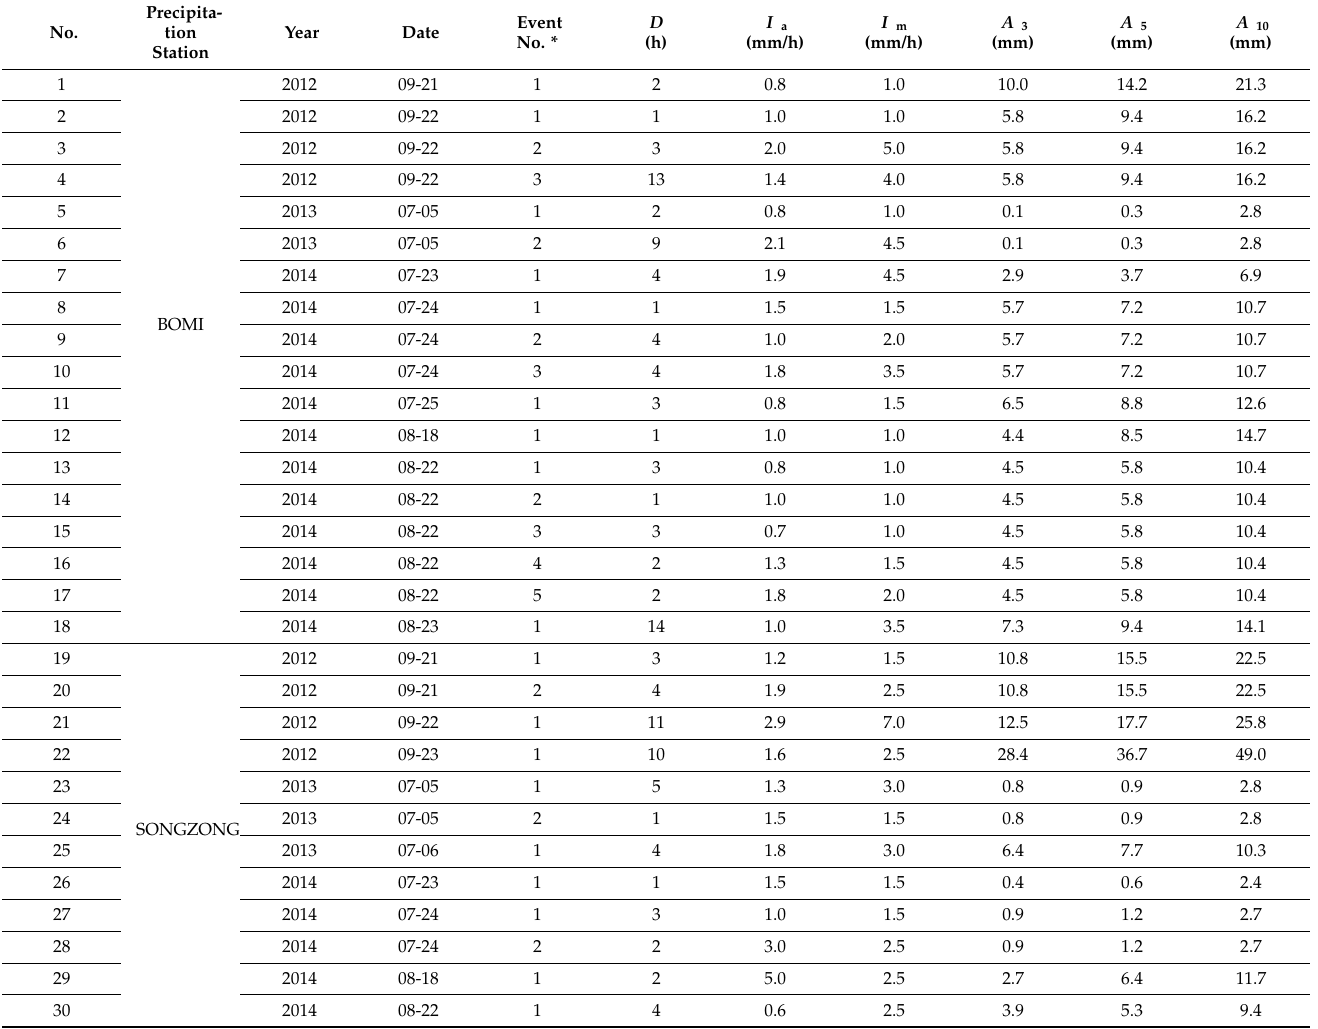
Table 3. Precipitation indicators data of related stations in training/validation phase